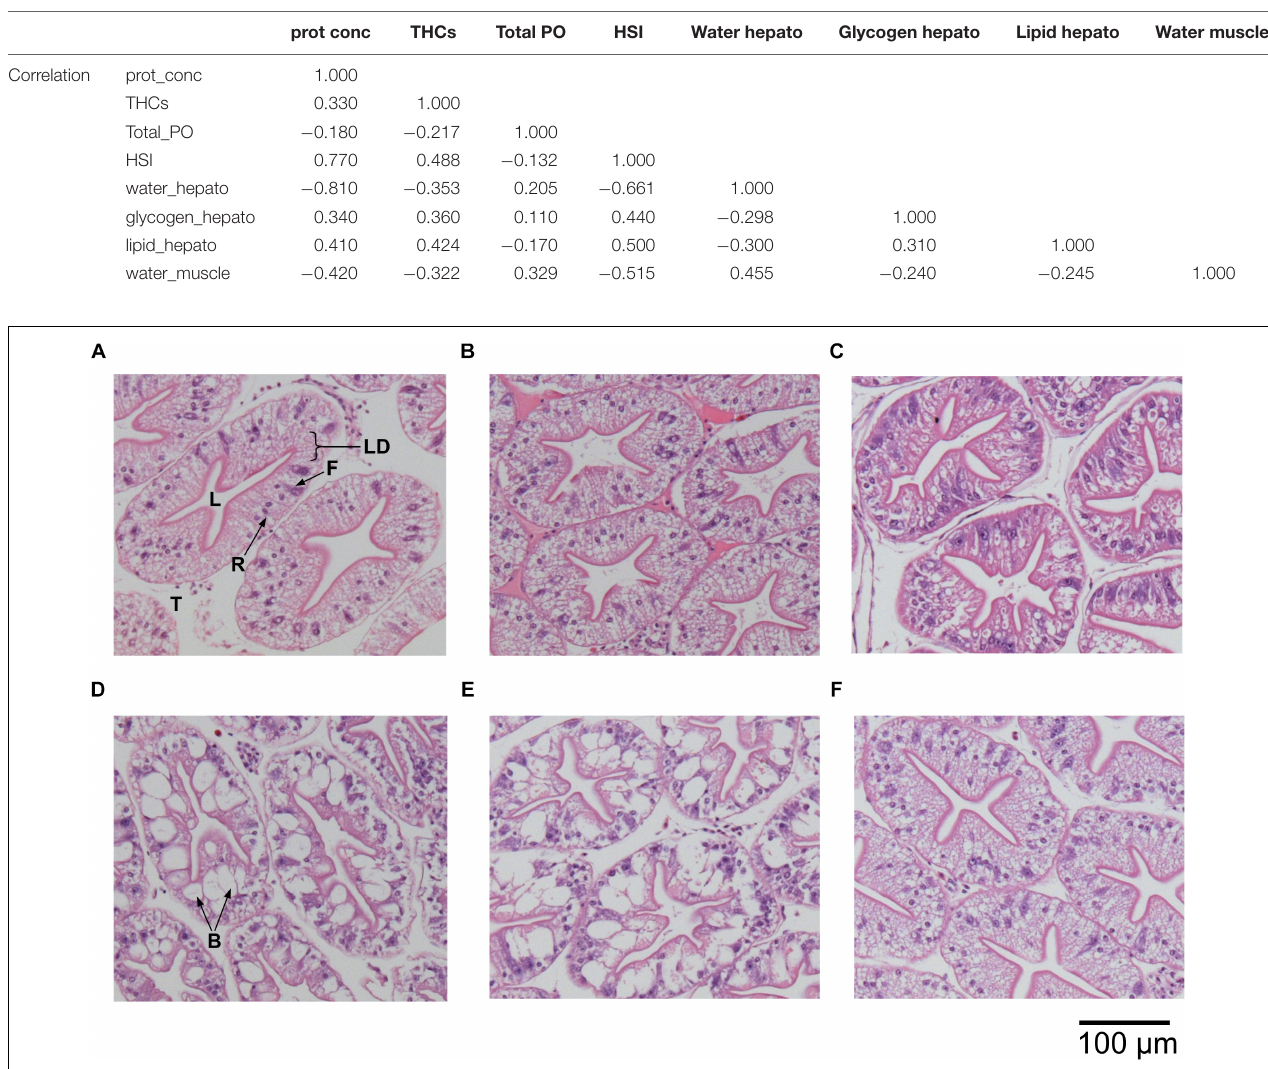
TABLE 7 | Correlation values between the variables included in the PCA analysis.